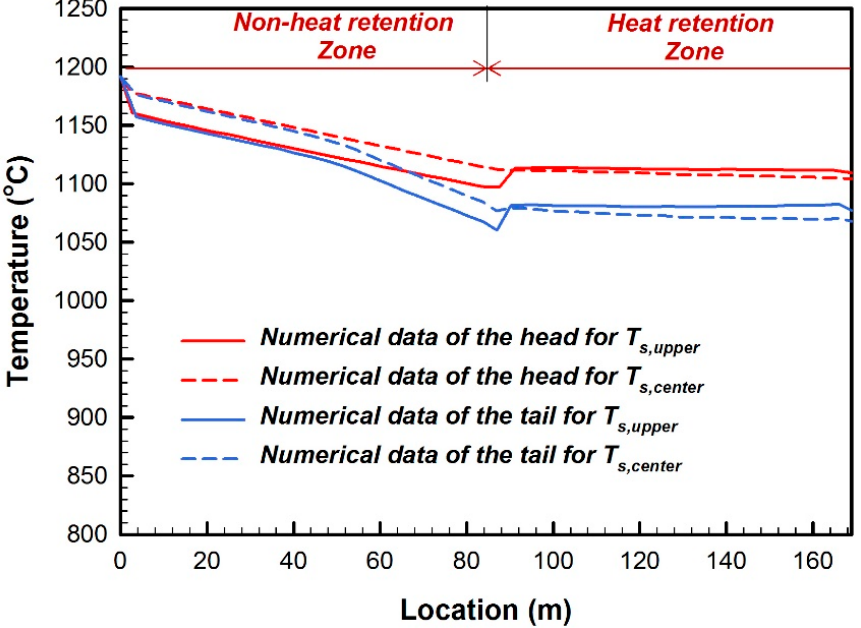
Figure 11. Numerical data for the upper surface and centerline-surface of the transfer bar with the acting-type heat retention panel (Case 1).